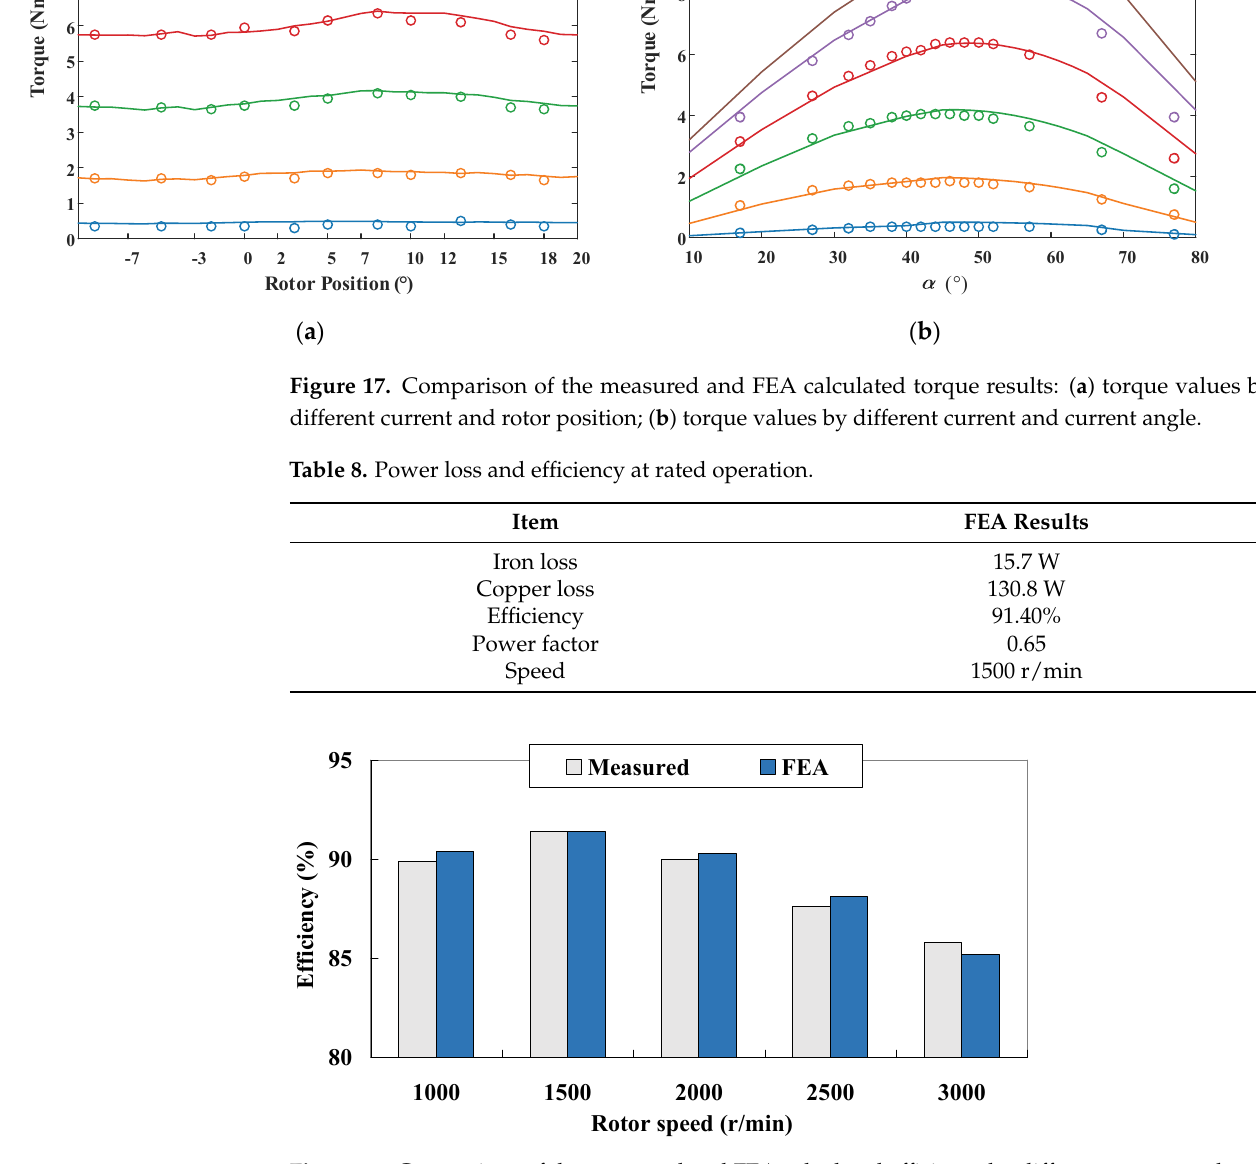
Figure 18. Comparison of the measured and FEA calculated efficiency by different rotor speed.